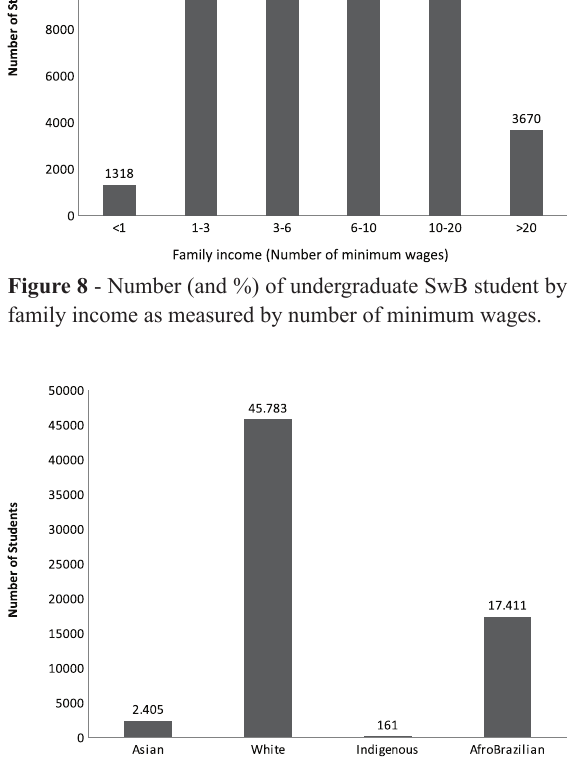
Figure 9 - Number of undergraduate SwB students by ethnic